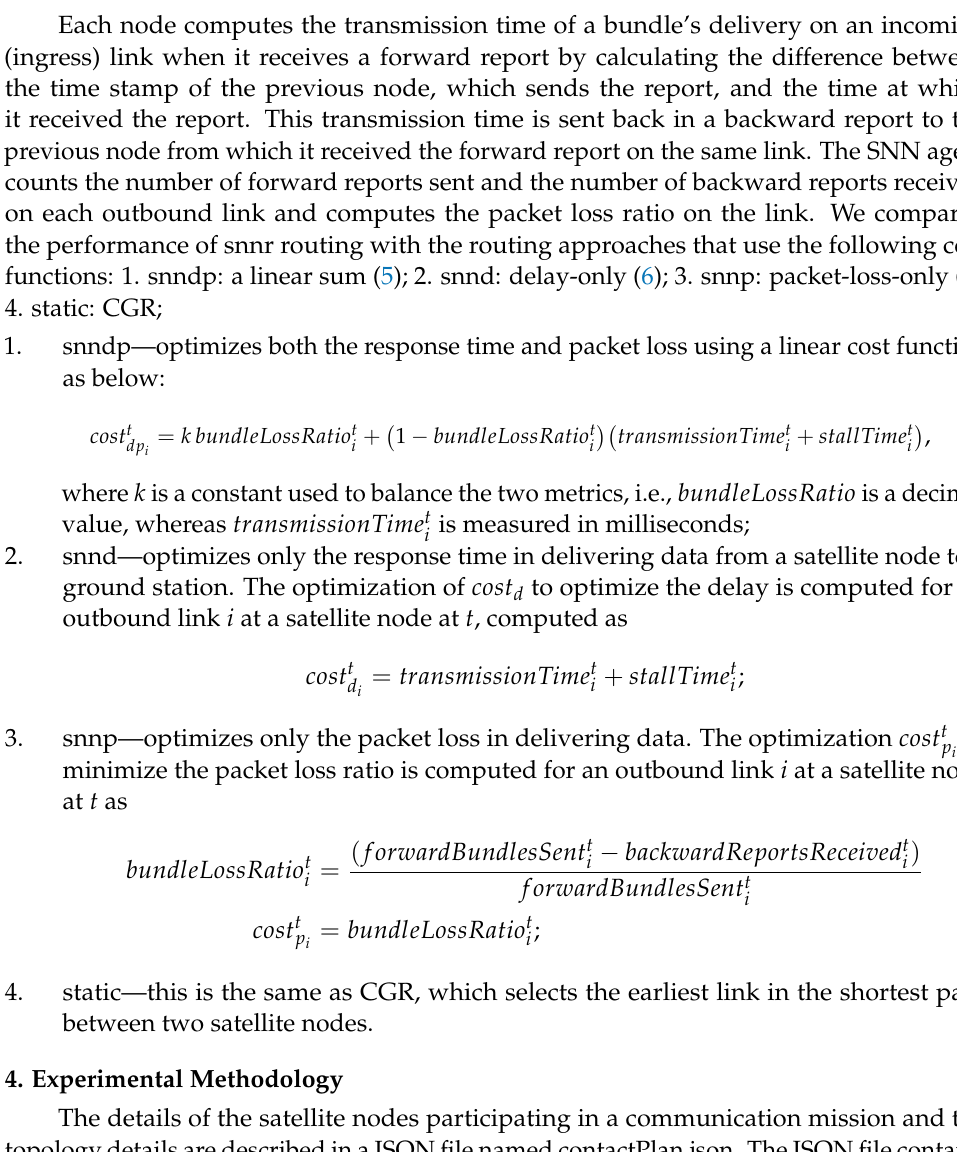
Figure 1. Cognizant controller running on satellites autonomously selects links at each satellite to optimize latency and pack loss in a possible interplanetary